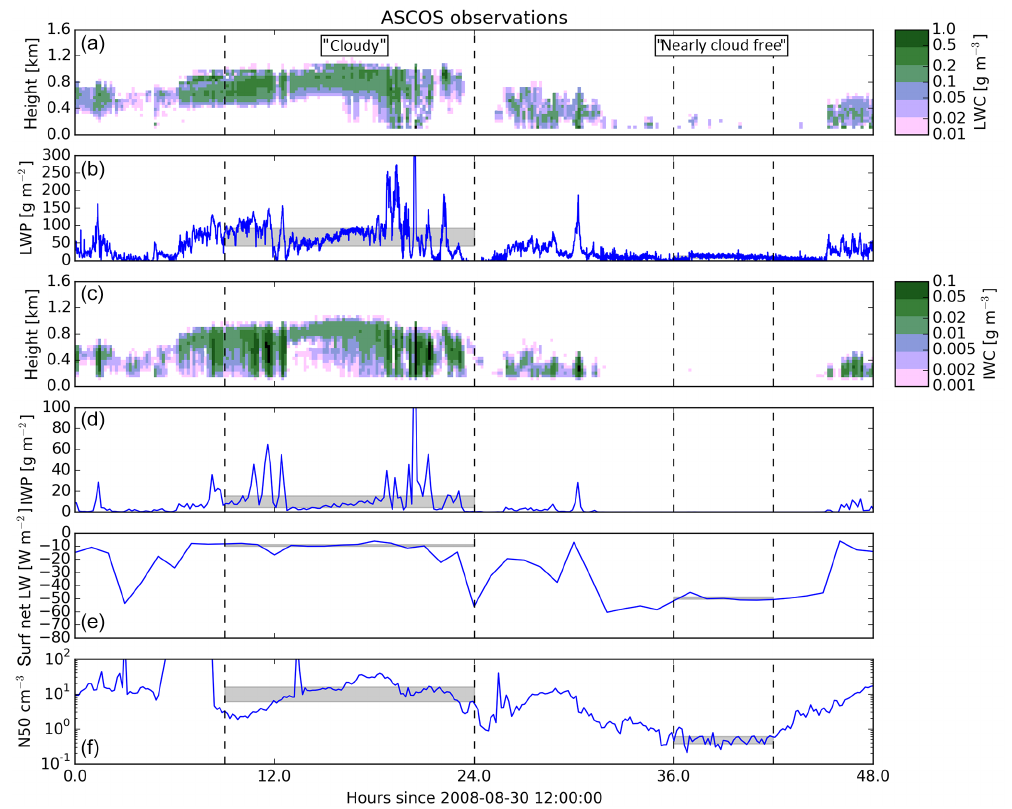
Figure 1. Observed cloud properties, surface radiation, and aerosol concentrations. (a) Liquid water content, (b) liquid water path, (c) ice water content, (d) ice water path, (e) surface net longwave flux, and (f) concentrations of N50. Shaded rectangles indicate the interquartile ranges of LWP, IWP, surface net LW radiation, and N50 during the cloudy and nearly cloud-free periods defined in Sect. 2. Dashed vertical lines indicate the beginnings and endings of these